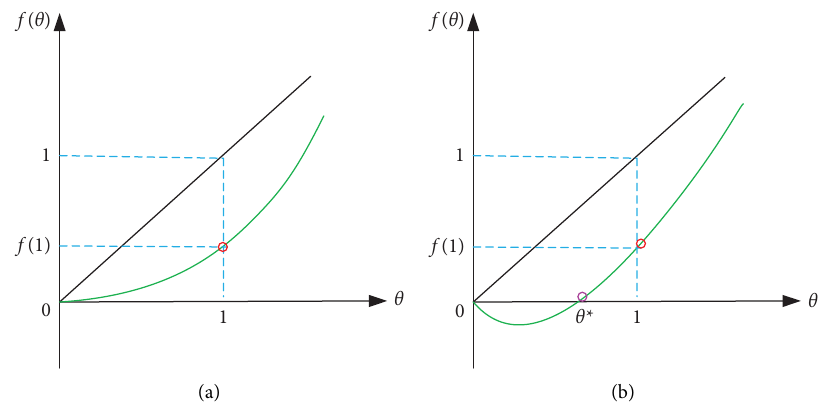
Figure 2: Diagram of solutions for f ( Θ ) in diferent